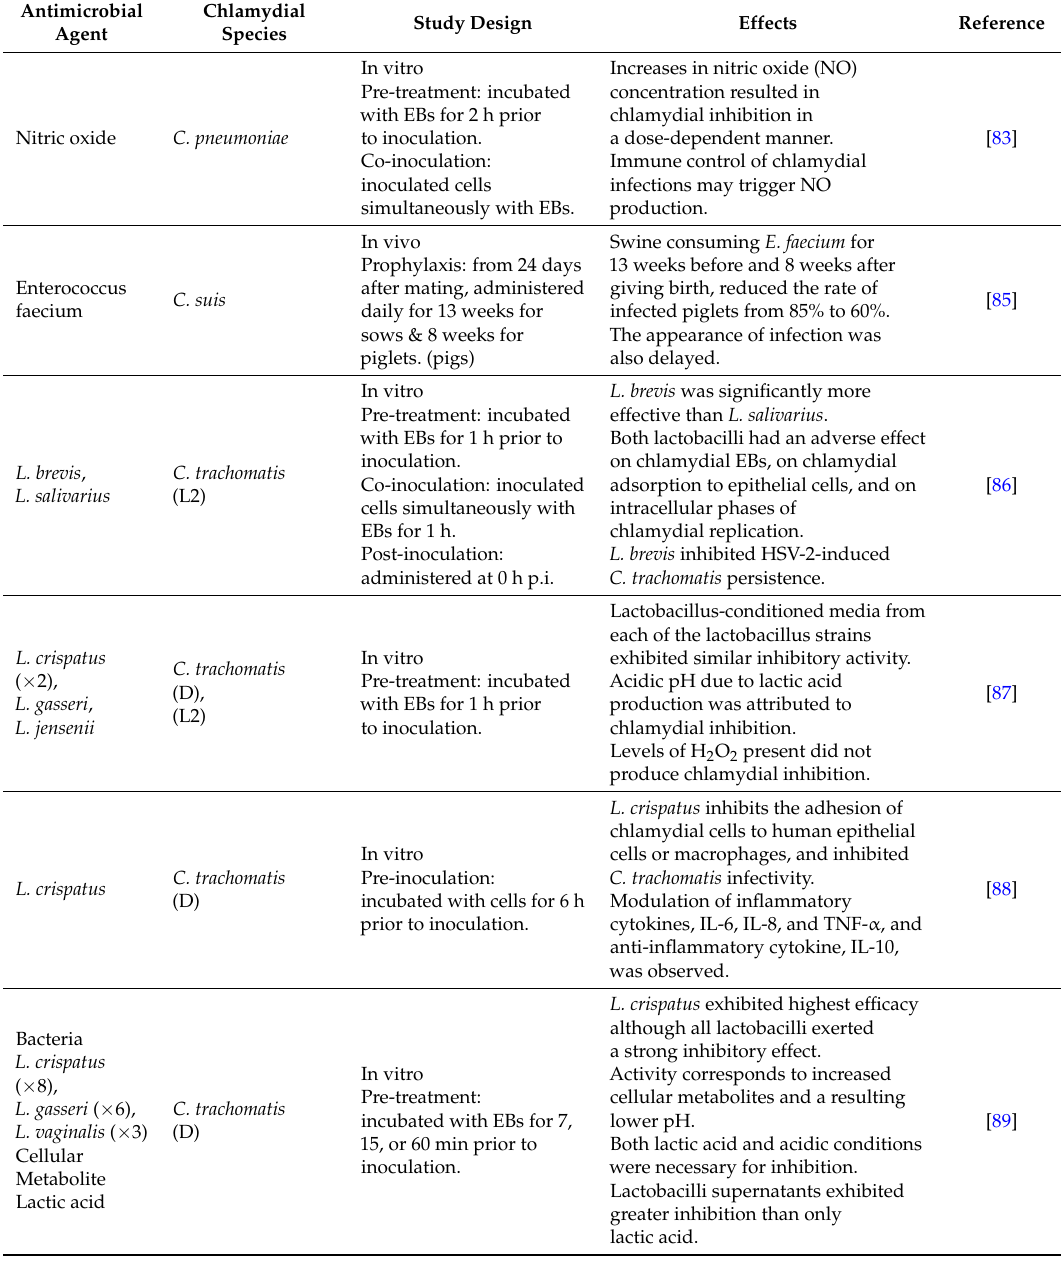
Table 5. Past studies exploring antichlamydial properties of cellular metabolites &